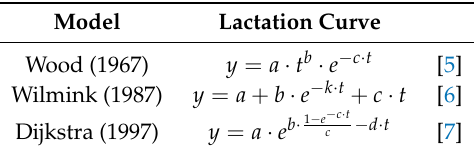
Table 3. Traditional regression